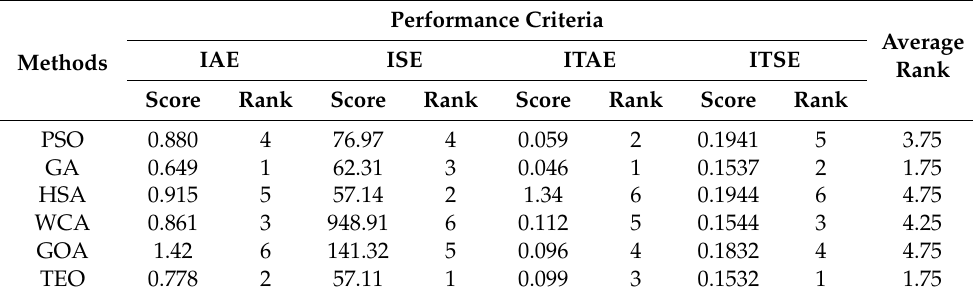
Table 3. Ranking of algorithms based on the statistical